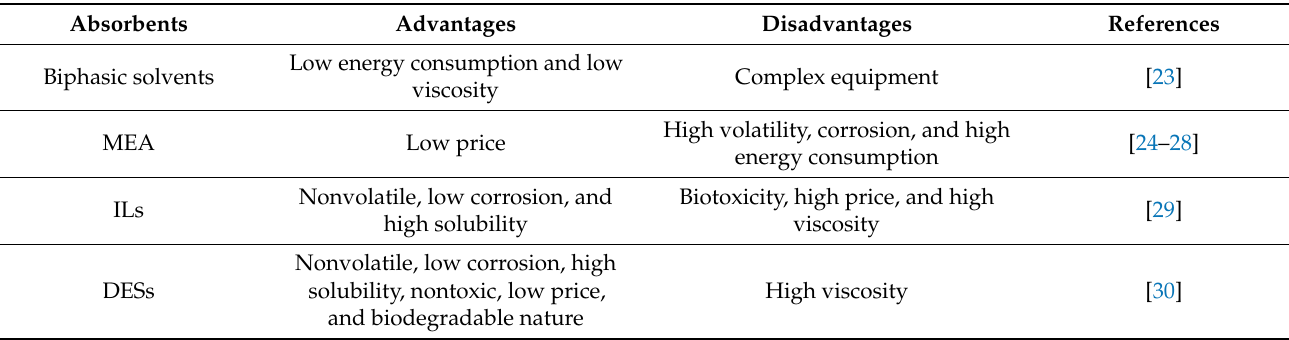
Table 1. Comparison of several generations of CO 2